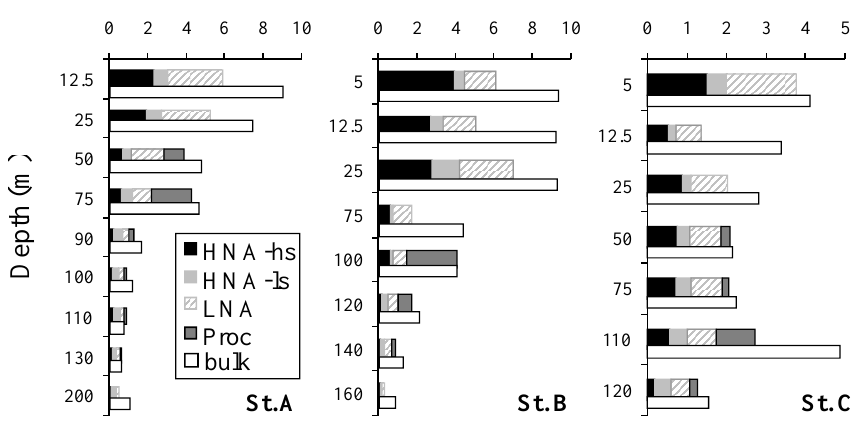
Fig. 6. Vertical distribution of summed volumetric rates of HNA-hs, HNA-ls, LNA and Proc compared to the bulk activity at stations St. A, B and C. Note that the depth scale varies from one profile to another.